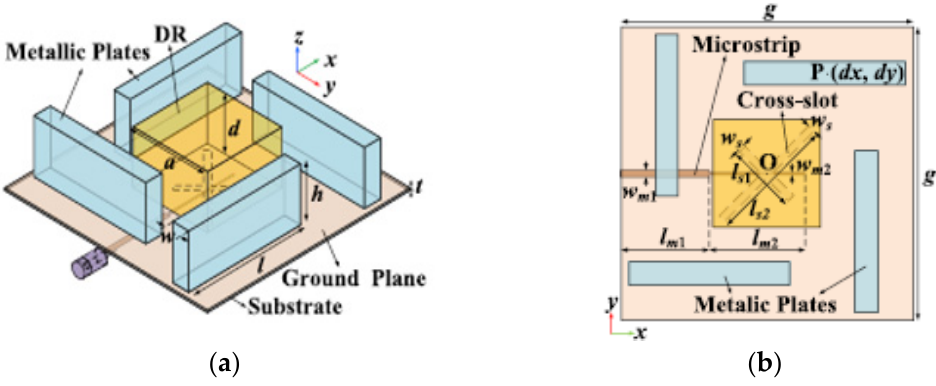
Figure 9. Proposed cross-slot-fed CP DRA: ( a ) perspective view; ( b ) top view [51].